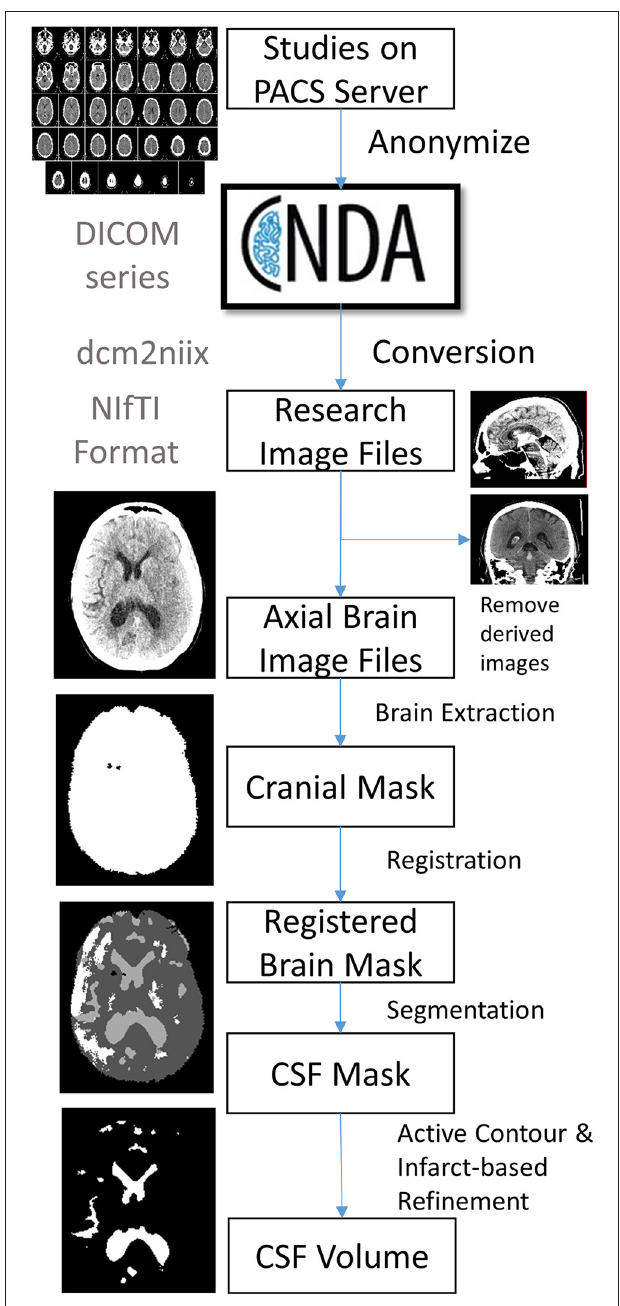
FIGURE 1 | Outline of image processing pipeline to analyze CSF volumes from large cohorts of stroke patients.